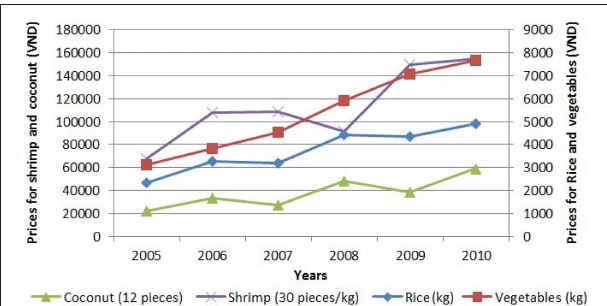
FIGURE 5 | Market prices of the most popular products in the Mekong Delta from 2005 to 2010. Source: Combined from various sources (BTCA, 2015; DARD, 2015; VASEP, 2015; VFA, 2015) (1USD ≈